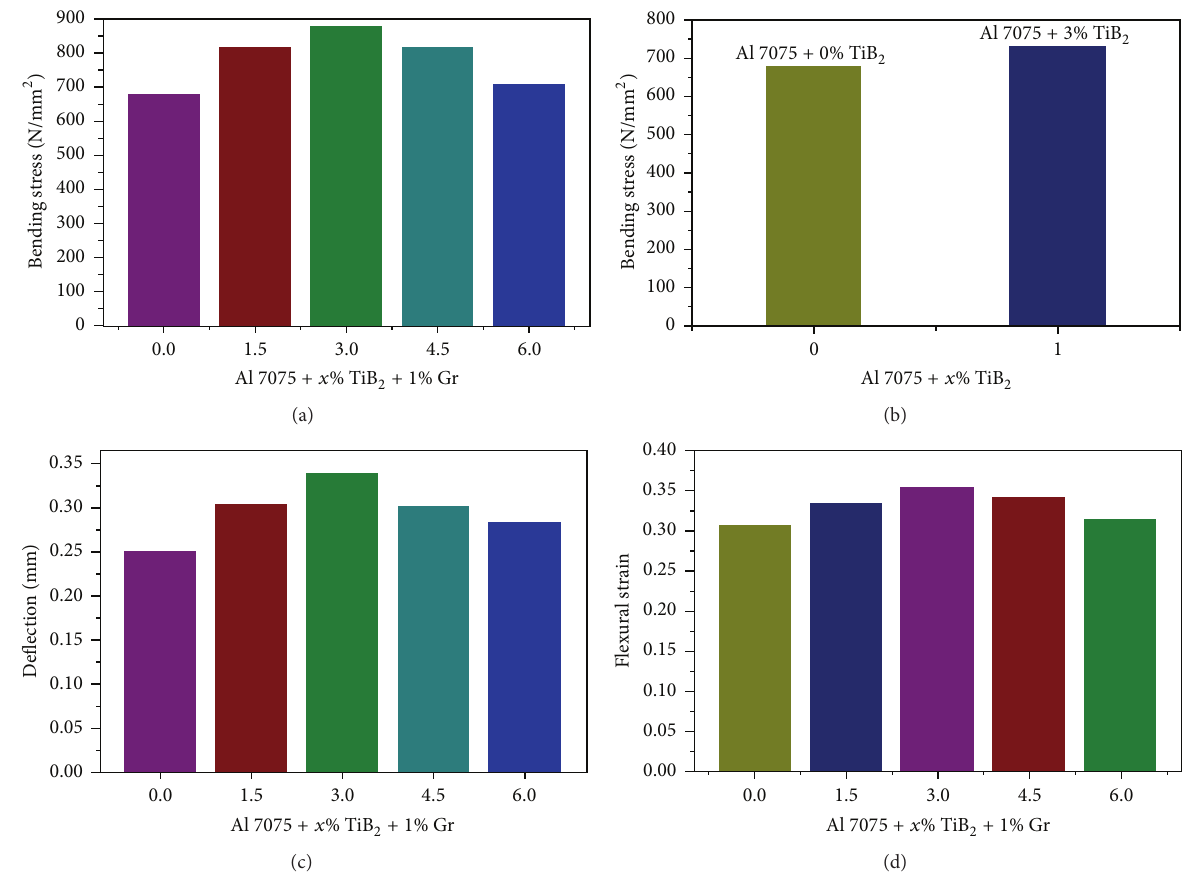
Figure 3: Bending stress for (a) Al 7075 + 𝑥 % TiB 2 + 1% Gr hybrid composites ( 𝑥 = 0, 1.5, 3, 4.5, and 6), (b) Al 7075 + 𝑥 % TiB 2 monocomposite ( 𝑥 = 0 and 3), (c) deflection for Al 7075 + 𝑥 % TiB 2 + 1% Gr hybrid composites ( 𝑥 = 0, 1.5, 3, 4.5, and 6), and (d) flexural strain for Al 7075 + 𝑥 = 0, 1.5, 3, 4.5, and 𝑥 % TiB 2 + 1% Gr hybrid composites (